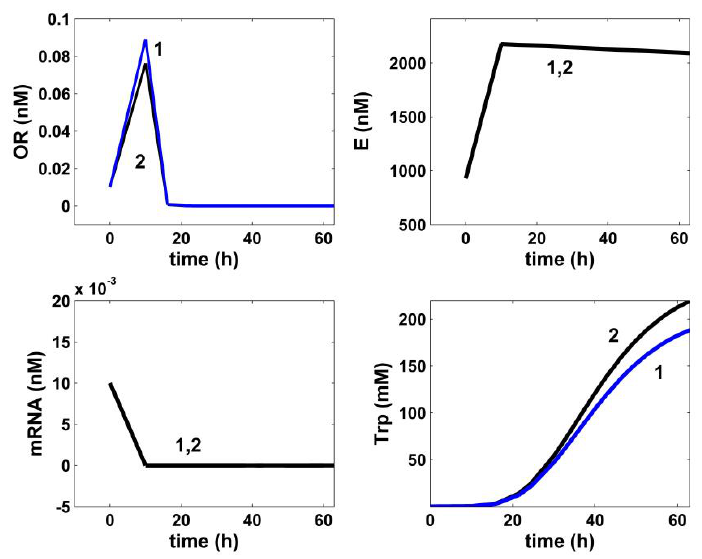
Table 1, with a constant fed [GLC] and a constant feed flow rate. Species abbreviations are given in the abbreviations list.